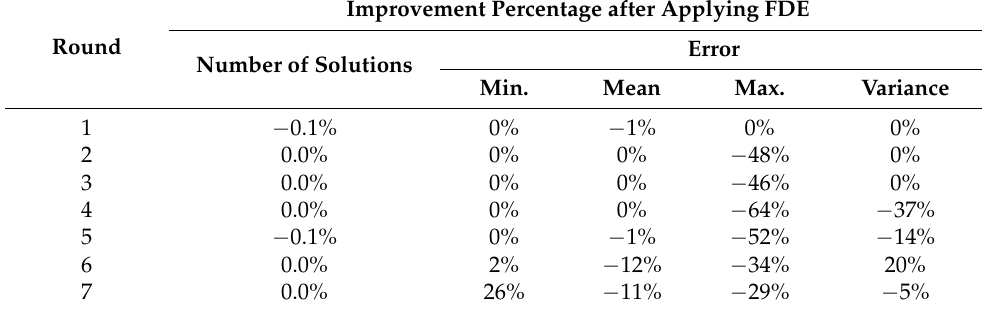
Table 4. Percentage variation of the obtained results when applying FDE. Improvement Percentage after Applying FDE Round Error Number of Solutions Min. Mean Max. Variance 1 − 0.1% 0%